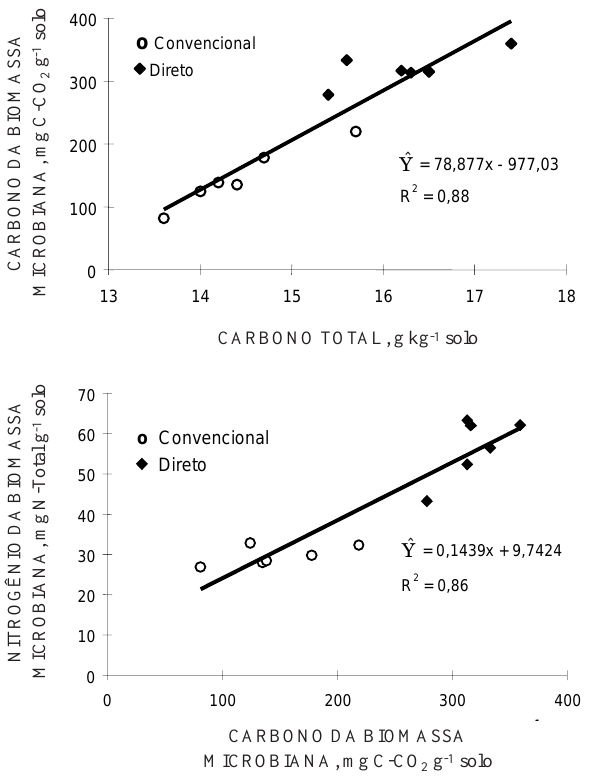
Figura 1. Regressão entre o carbono da biomassa microbiana e o carbono total e entre o nitrogênio da biomassa microbiana e o carbono da biomassa microbiana (preparo convencional e plantio direto) para 12 dados a 0,1%.